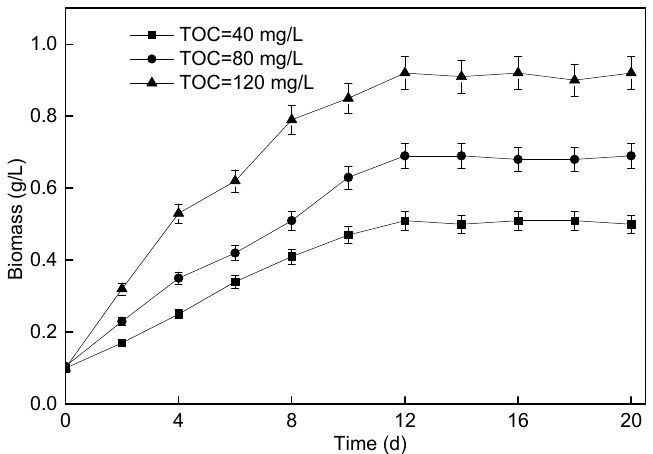
Figure 4. Changes in P. helgolandica tsingtaoensis biomass concentration under different influent TOC.